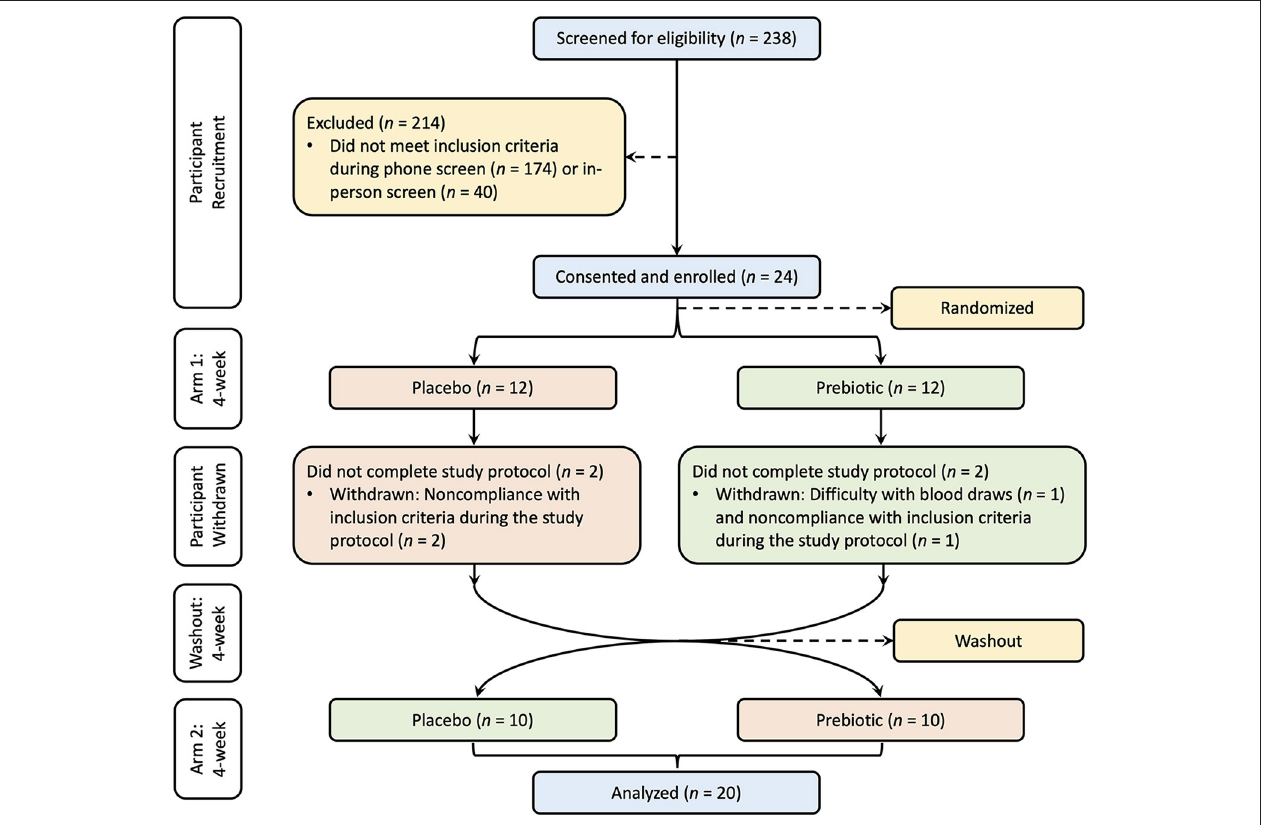
FIGURE 1 | Study CONSORT diagram. Participants were recruited with screening, consent, and enrollment process. The treatment order was randomized into two groups, one group (red) supplemented with the placebo and the other group (green) supplemented with the prebiotic followed by a washout period and crossover to the other treatment for each